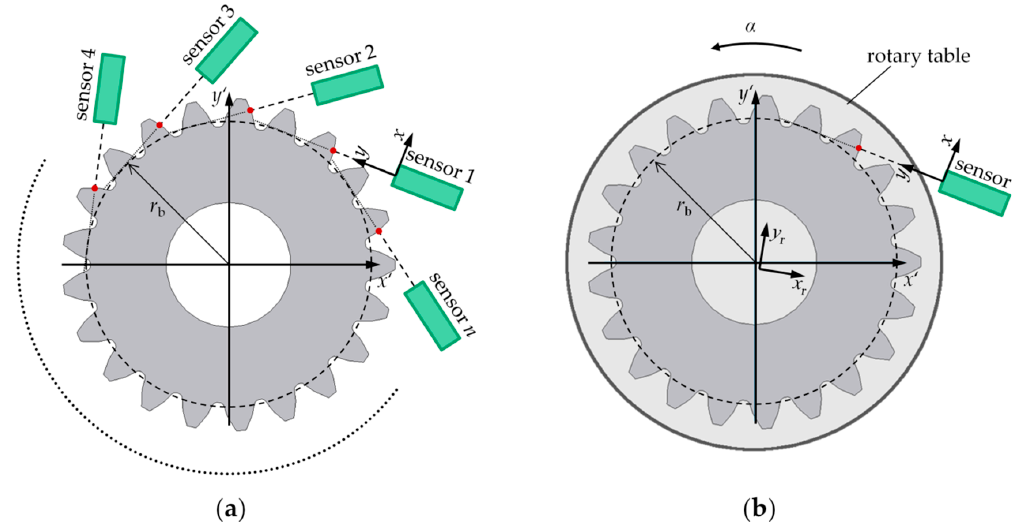
Figure 2. Model-based multi-distance measurement principles consisting of ( a ) a multisensory system with n optical distance sensors in a common measuring coordinate system ( x , y ) measuring the tooth contour of a non-modified spur gear with a workpiece coordinate system ( x’ , y’ ) and ( b ) a single-sensor system ( x , y ) in combination with a rotary table ( x r , y r ) measuring continuously the tooth contour of a spur gear ( x’ , y’ ) depending on the rotation angle α .